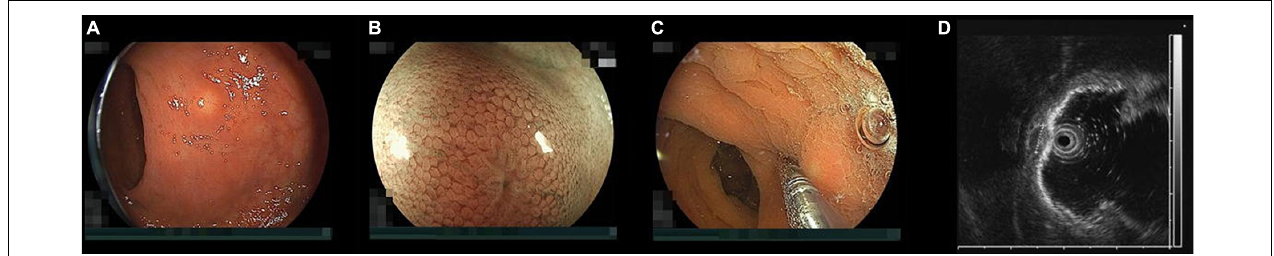
FIGURE 1 | Endoscopic findings of a rectal neuroendocrine tumor (NET). (A) Typical rectal NET endoscopically looks like a yellow submucosal tumor covered with normal mucosa (B) magnified view shows “expanded normal pit pattern” because NETs originate from the deep mucosa and expansively grow toward the submucosa through the muscularis mucosa expanding the pits on the surface of the mucosa covering the NET. (C) When pushing a NET using the tip of a miniature probe, the NET moves with its mucosa but a submucosal tumor from the muscularis separately moves under the mucosa. (D) Endoscopic ultrasound at 20 MHz can correctly distinguish a NET from a submucosal tumor. The high-echoic submucosal layer can be identified between the NET and the muscularis. The NET was measured 5.2 mm in diameter with measuring function prepared to an endoscopic ultrasound